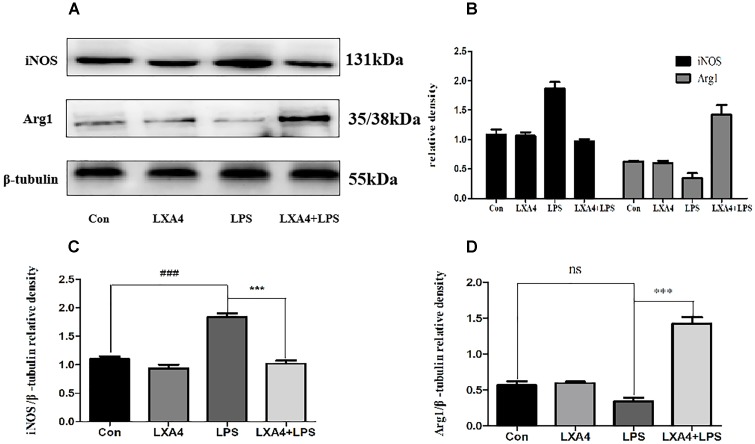
Western blot analysis of the effect of LXA4 on iNOS and Arg1. (A–C) Western blot analysis of the protein level of iNOS in microglia. (A,B,D) Western blot analysis of the protein level of Arg1 in microglia, LPS upregluated M1 microglia biomarkers iNOS. With LXA4 intervention, iNOS expression decreased, M2 microglia biomarkers Arg1 expression increased significantly. ###,∗∗∗p < 0.001; n.s., no significance.